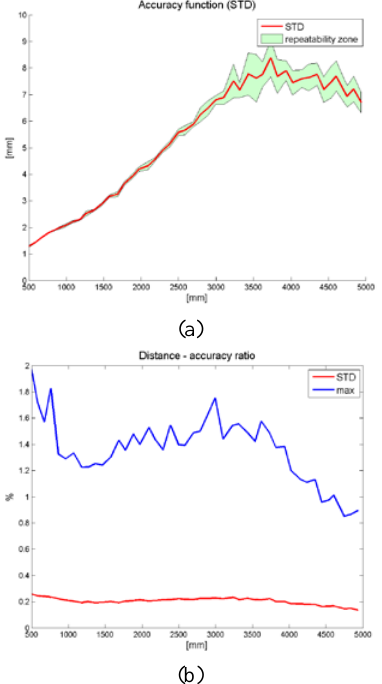
Figure 6. STD of residual surface fitting errors (a), and normalized statistical parameters (b).